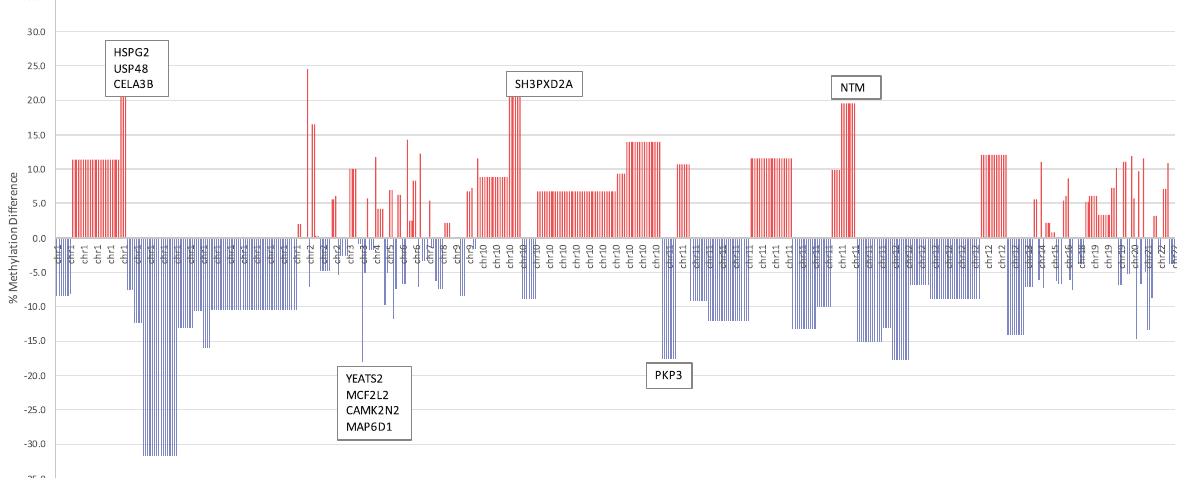
Fig. 3 Differentially methylated sites represented to display average methylation differences as a function of genomic regions. Bar graph of individual CpG sites that were differentially methylated in ACS-exposed subjects as compared to unexposed controls (DMC). Each bar represents a DMC, visualized across the genome displayed along the x-axis. Average methylation difference % is represented along the y-axis such that adjacent bars of same height represent DMCs that are located within the same region. Labelled are the top ten differentially methylated